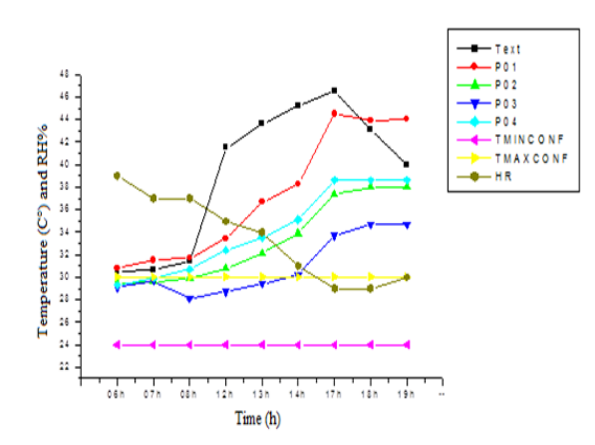
Figure 17. Internal and external temperatures variation during the